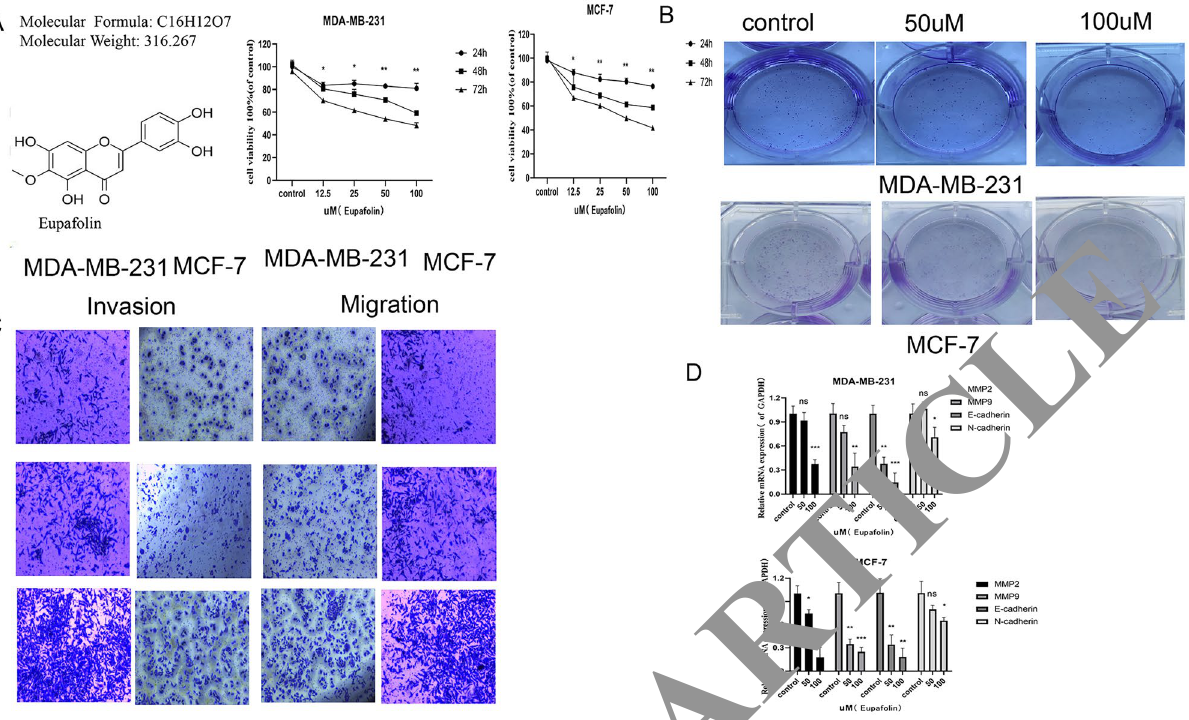
Figure 1. The effects of Eupafolin on the sensitivity of breast cancer cells. ( A , B ) MDA-MB-231 and MCF-7 cells were exposed to various concentrations of Eupafolin (0, 12.5, 25, 50 and 100 µM) for different times. The